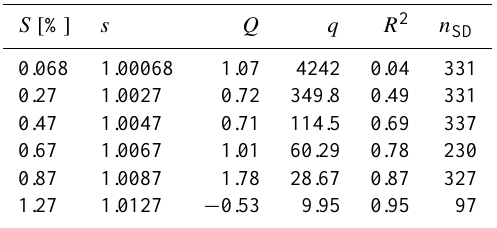
Table 4. Fit parameter Q and q of the fit functions N CCN , S = N CN , 30 · (S/( 1% )) Q and N CCN , S = N CN , 30 · s − q , respec- tively. The correlation coefficient R 2 is the same for both fits. n SD is the number of data points.